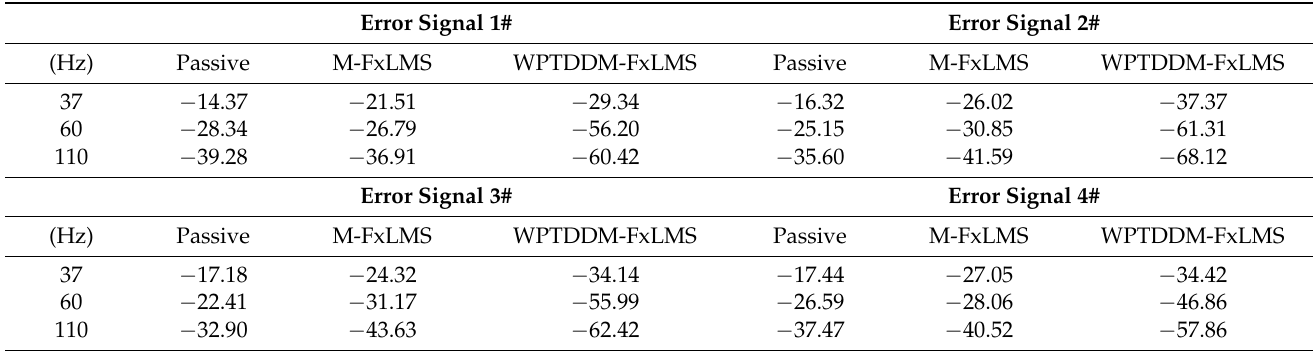
Figure 13. ( a ) The time domain acceleration signal in measuring point 4#; ( b ) the acceleration signal spectrum in measuring point 4#. Table 1. Simulation results with two algorithms.